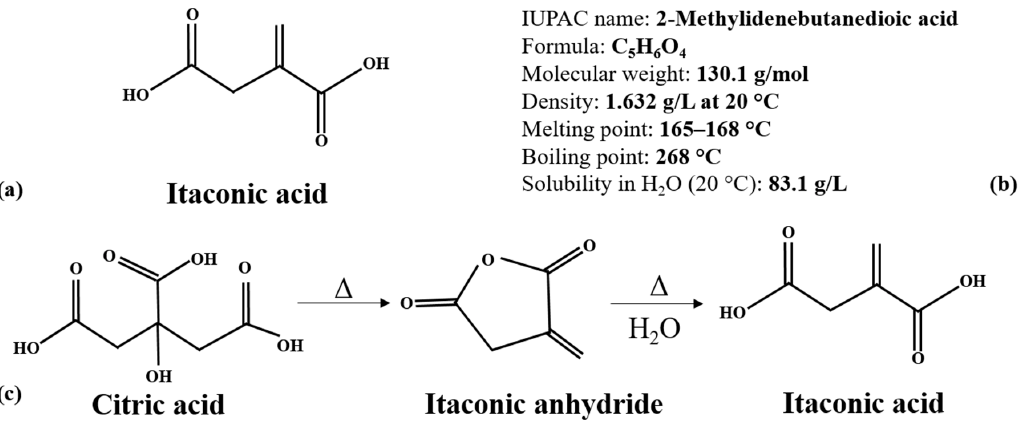
Figure 1. The chemical structure ( a ), properties ( b ) and chemical synthesis from citric acid ( c ) Δ : heat input.